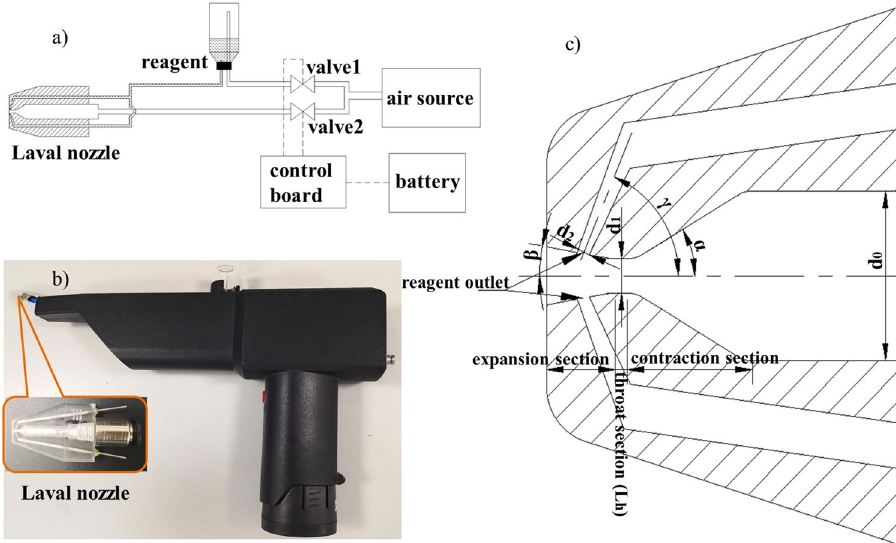
Figure 1. ( a ) Schematic diagram of the system; ( b ) the prototype of the device; ( c ) structure of the Laval